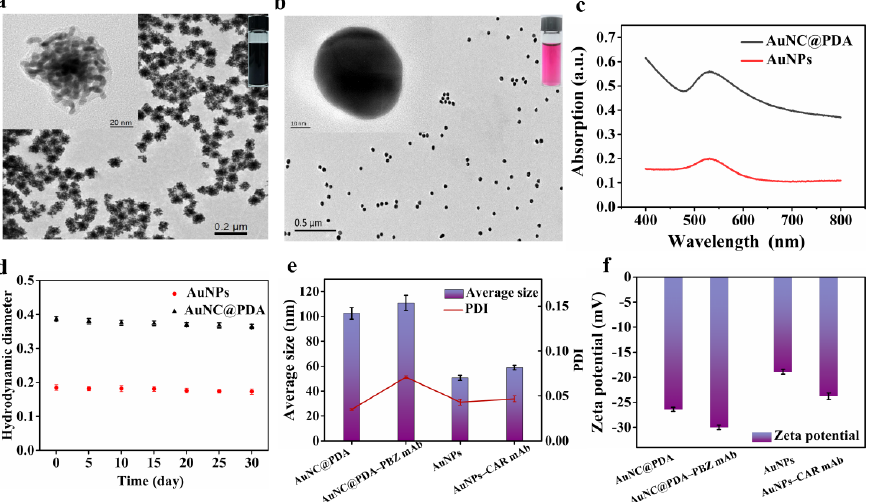
Figure 2. Characterization of AuNC@PDA and AuNPs. ( a ) TEM of AuNC@PDA. ( b ) TEM of AuNPs. The corresponding insets in ( a , b ) were obtained using high-resolution transmission electron micros-